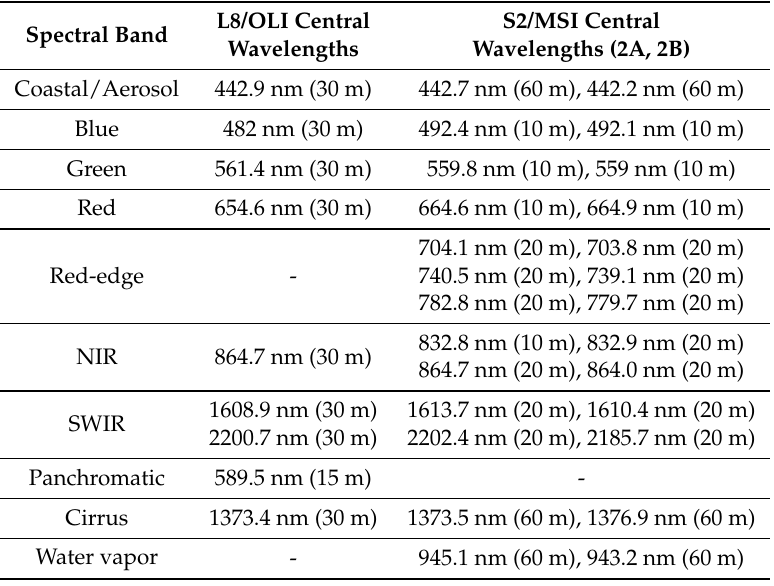
Table 1. Characteristics of L8/OLI and S2/MSI